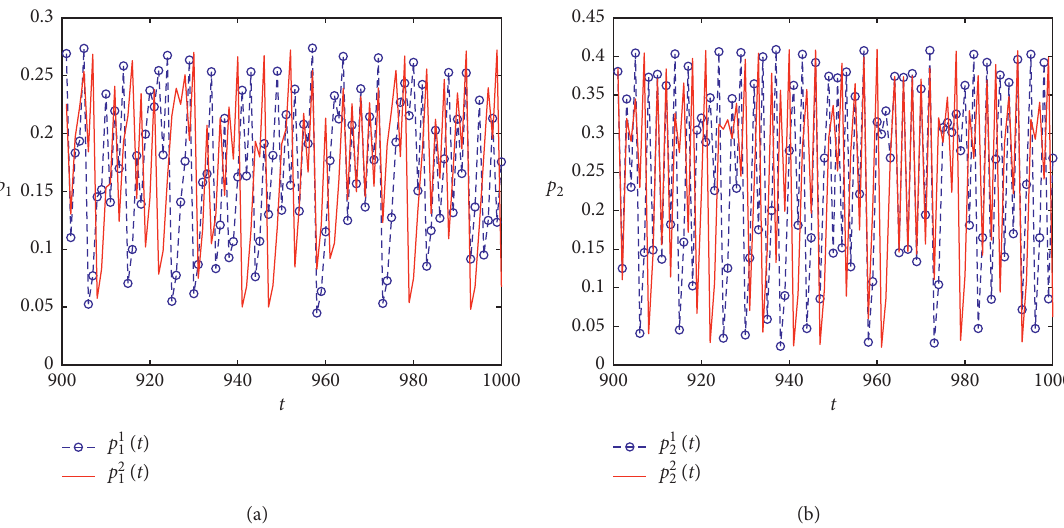
Figure 7: Sensitive dependence on initial conditions for system (38) in the time periods [900, 1000] when k